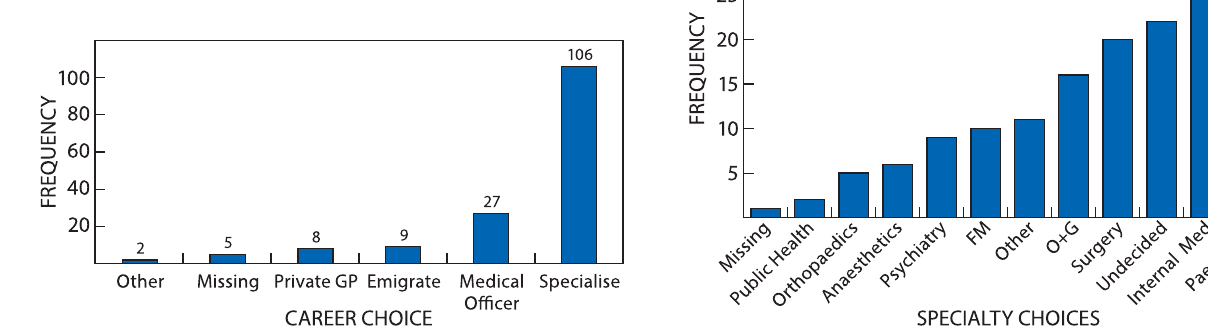
Figure 2: Students ’ career choices. Figure 3: Final-year students ’ specialty